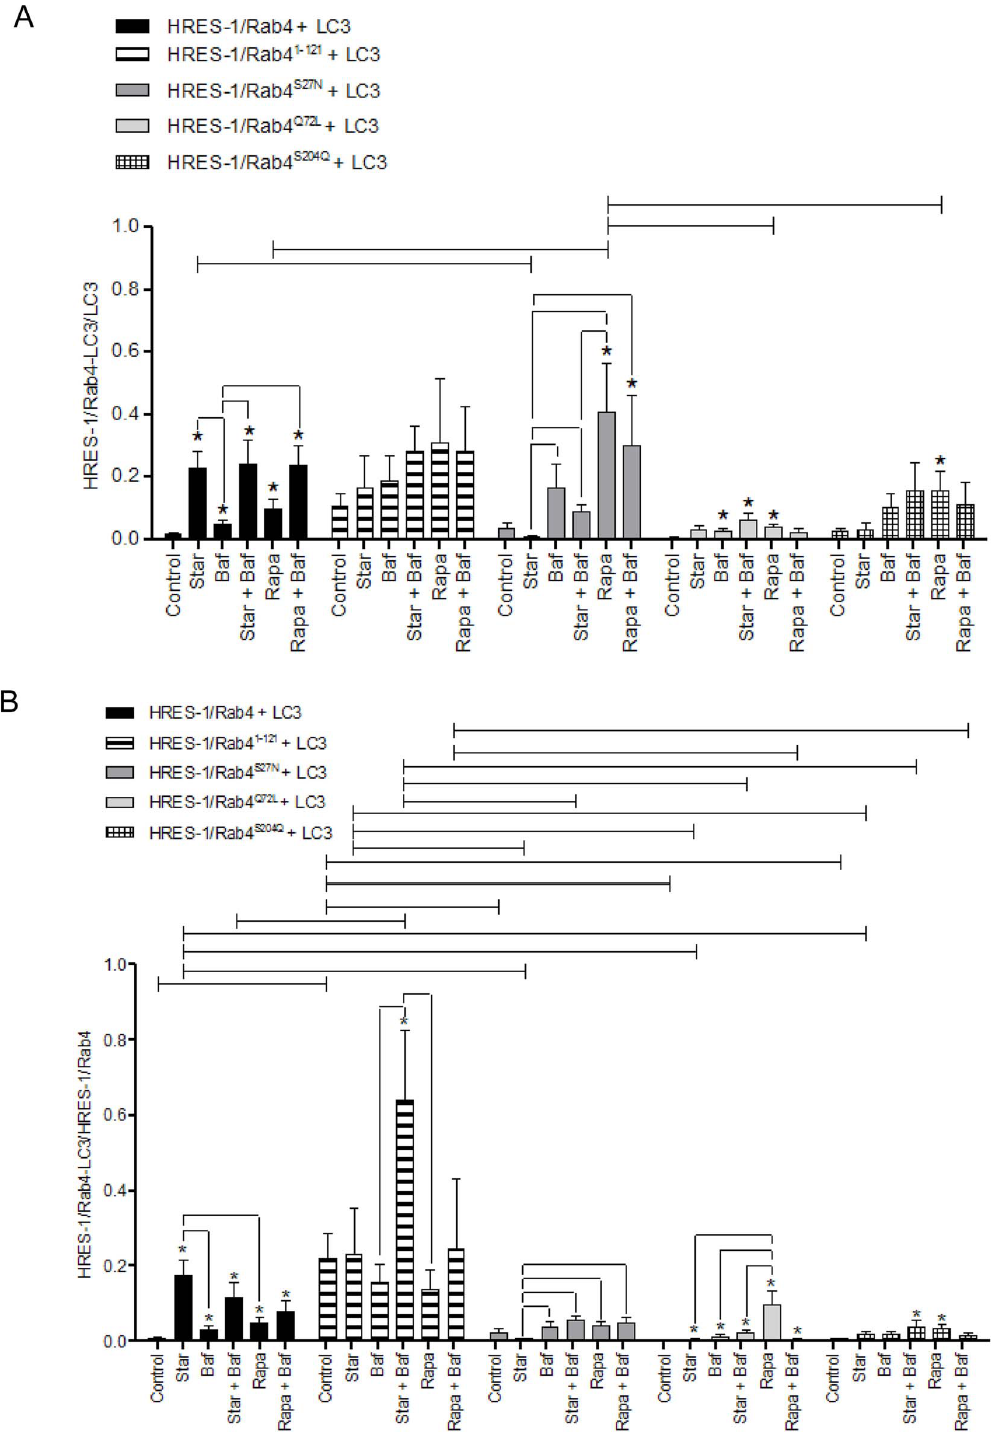
Figure 3. Cumulative analysis of colocalization of HRES-1/Rab4 and LC3 induced by starvation and rapamycin. Colocalization of HRES- 1/Rab4 and LC3 was quantified relative to total LC3 (panel A) and total HRES-1/Rab4 content (panel B). The colocalization of HRES-1/Rab4 with LC3 was most profoundly skewed by HRES-1/Rab4 S27N which blocked colocalization under starvation and promoted colocalization during mTOR blockade. In contrast to HRES-1/Rab4 S27N , HRES-1/Rab4 Q72L blocked colocalization with LC3 both under starvation and mTOR blockade. Data represent mean 6 SEM of 6–29 cells acquired in 3 independent experiments. * indicates p values , 0.05 reflecting comparison to control cells among cell cultures transfected with the same construct using paired two-tailed t-tests; brackets connecting bars within each construct also reflect comparison with paired two-tailed t-tests. Brackets connecting bars between constructs reflect p , 0.05 using ANOVA followed by Bonferroni’s post- test.